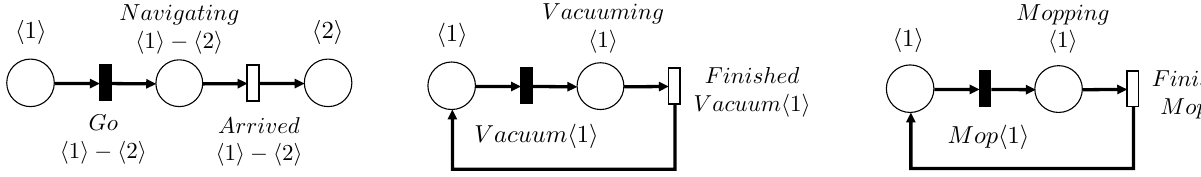
Figure 3. ( Left ) Navigation action model; ( Center ) Vacuuming action model; ( Right ) Mopping action